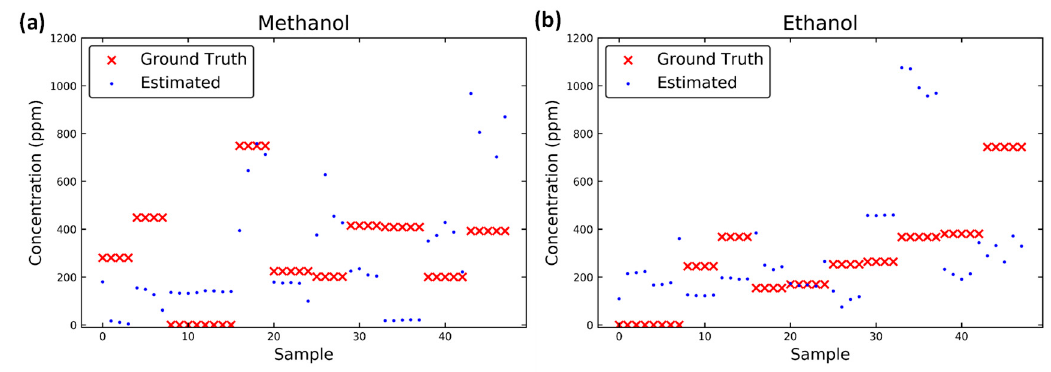
Figure 9. Estimated concentration of ( a ) methanol and ( b ) ethanol in each sample obtained with the method in Madrolle’s study [14]. The ground truth in red is presented for a comparison with the estimated results.